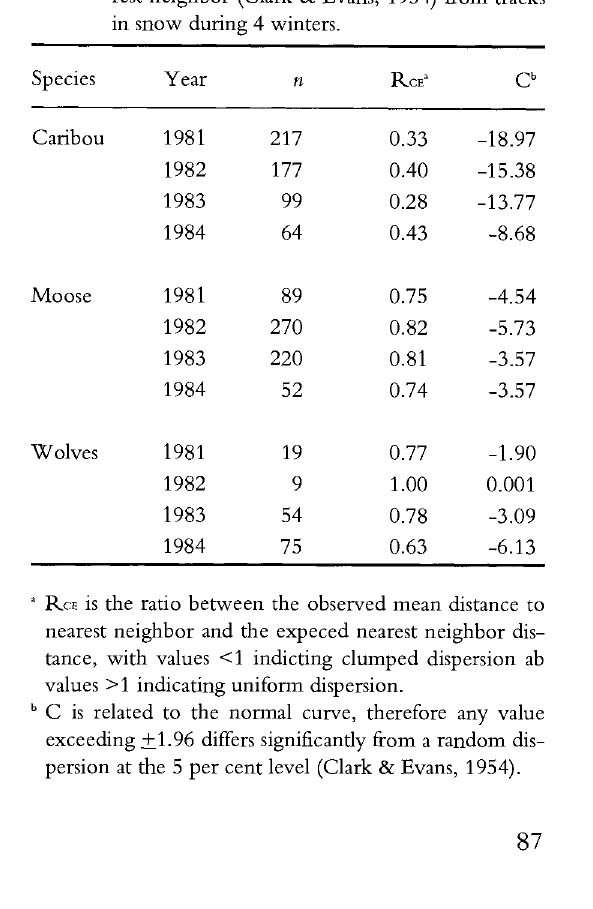
Table 2. Dispersion of caribou, moose and wolves in nor thern Ontario as measured by distances to nea rest neighbor (Clark & Evans, 1954) from tracks in snow during 4 winters.